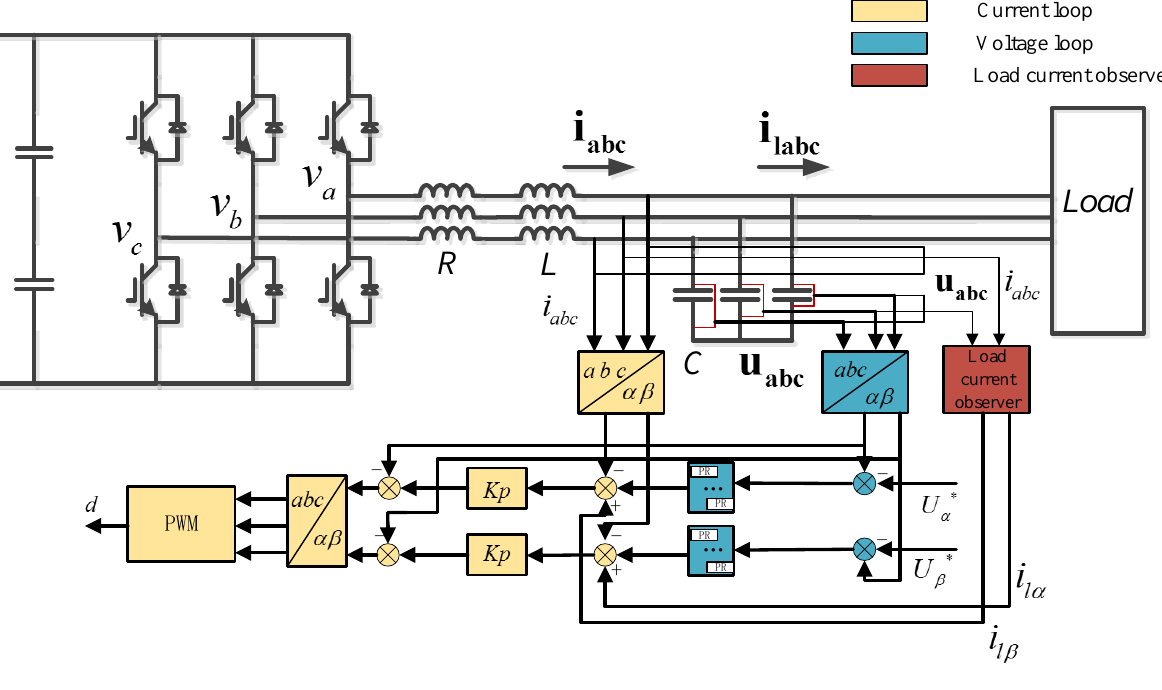
Figure 7. Inverter control system under stationary frame.